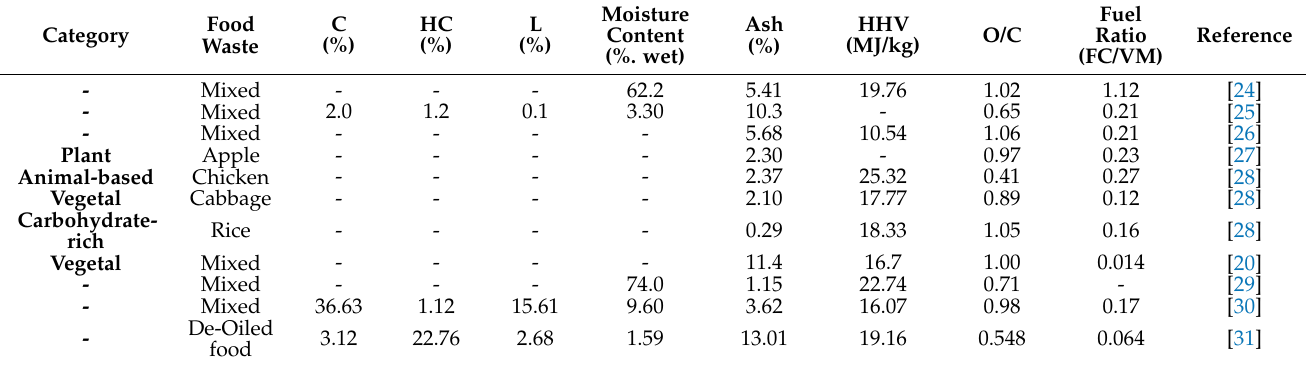
Table 1. Characteristic of previously reported food wastes (dry